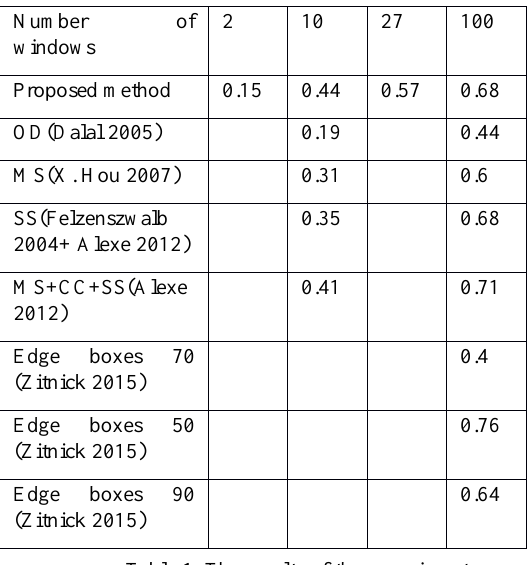
Table 1. The results of the